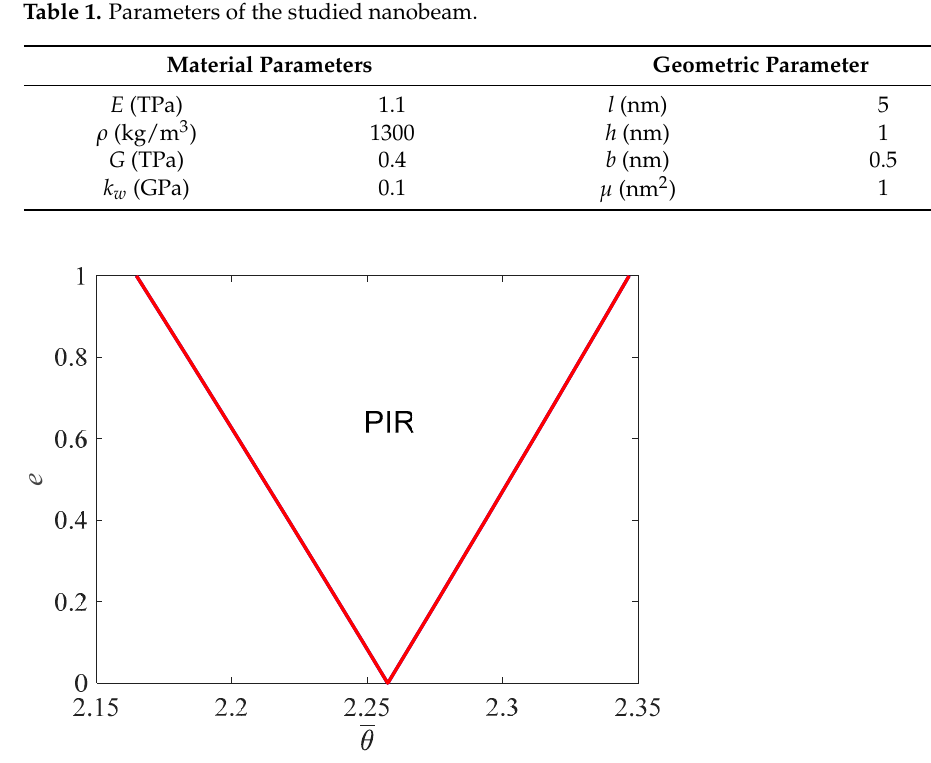
Figure 2. Boundary of PIR of the Reddy nanobeam.